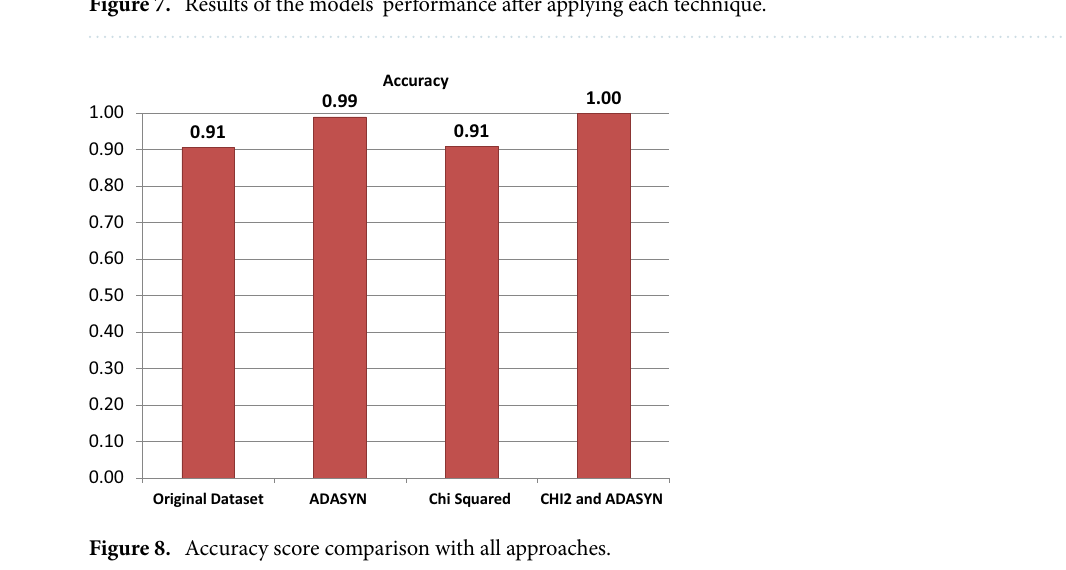
Figure 8. Accuracy score comparison with all approaches.